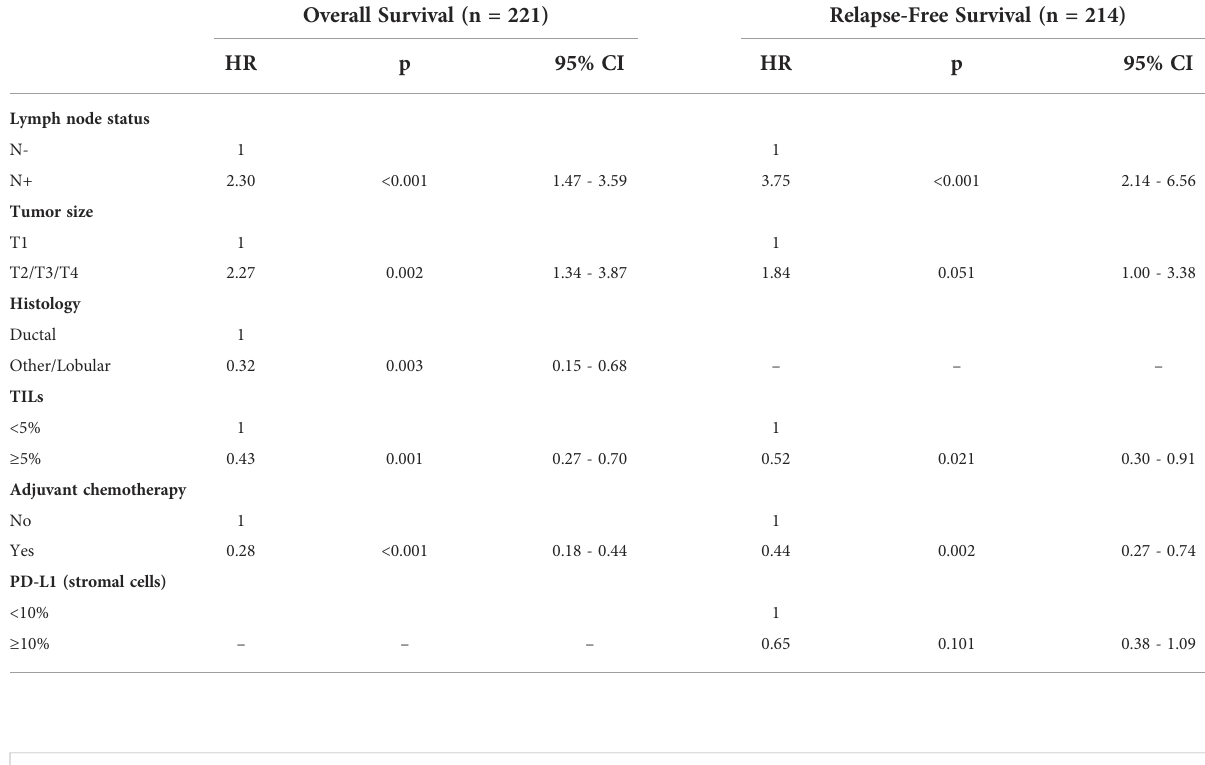
TABLE 4 Multivariate analysis of clinicopathological variables associated with relapse-free survival and overall survival.